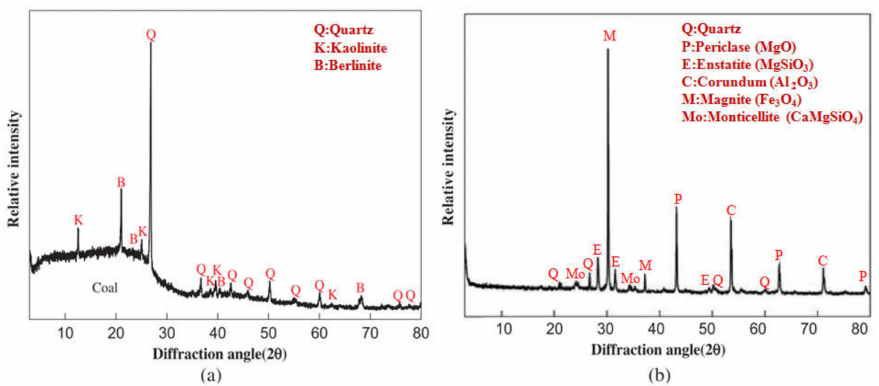
Figure 7. Wavelength dispersive X-ray diffraction spectra for ( a ) pre-explosion and ( b ) post-explosion for Laohutai coal dusts [257].